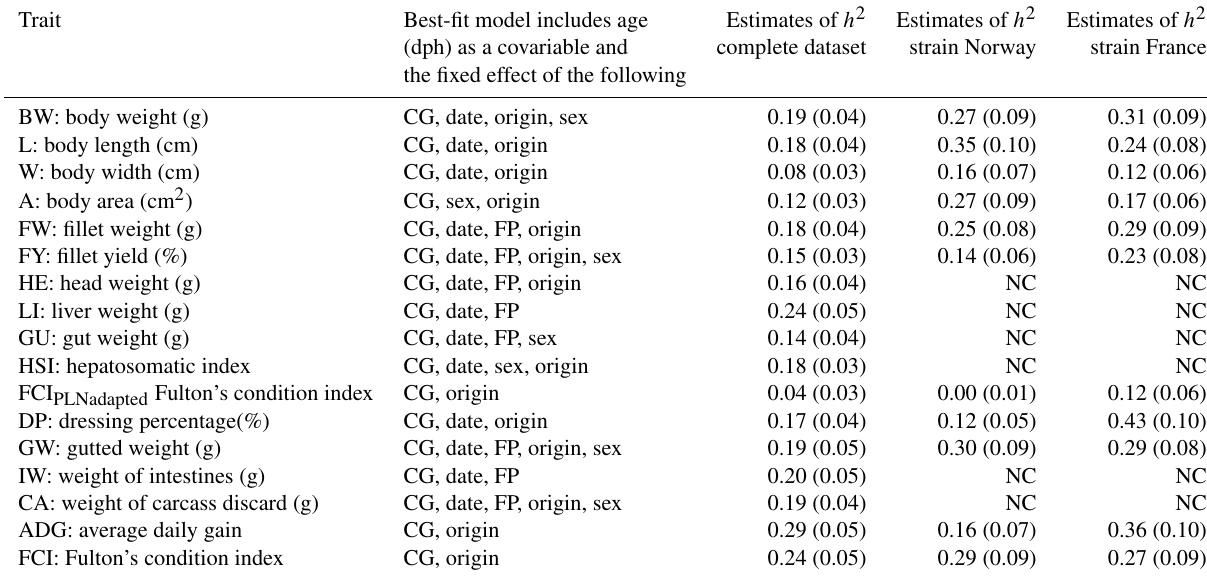
Table 3. Estimates of heritability ( h 2 ) in the complete and strain-wise datasets: fixed effects are included in the model based on significance (chi-square: p< 0 . 05). CG: contemporary group; date: date of slaughter; FP: filleting person, BW: body weight at slaughter (g); L: body length (cm); W: body width (cm); A: body area (cm 2 ); FW: fillet weight (g), FY%: fillet yield (%), HE: head weight (g), LI: liver